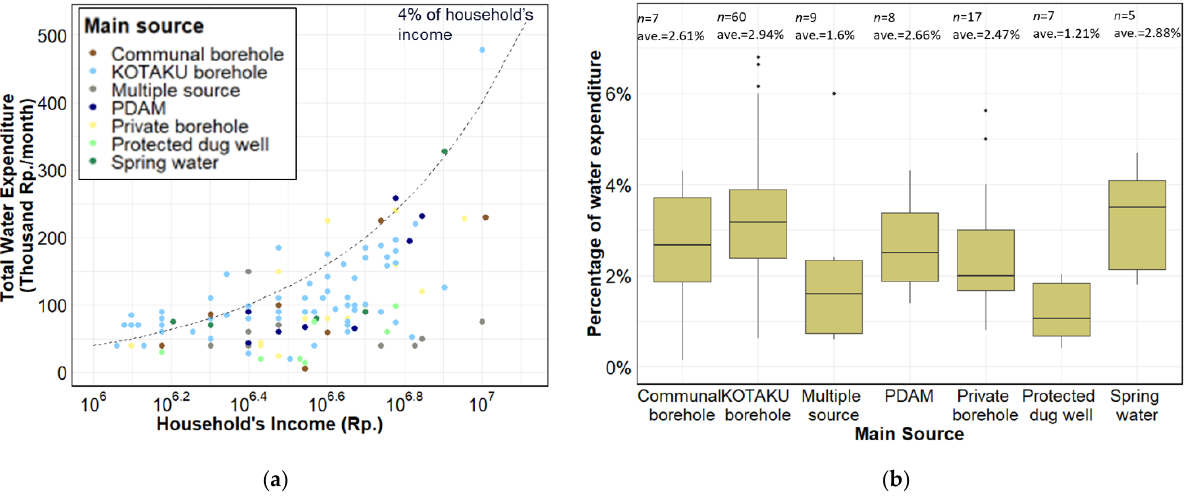
Figure 8. ( a ) Monthly total water expenditure and household income with four percent indicator; ( b ) percentage of monthly water expenditure in monthly income for each main source user. IDR 1000 = 0.0675 USD (as of 27 June 2022).